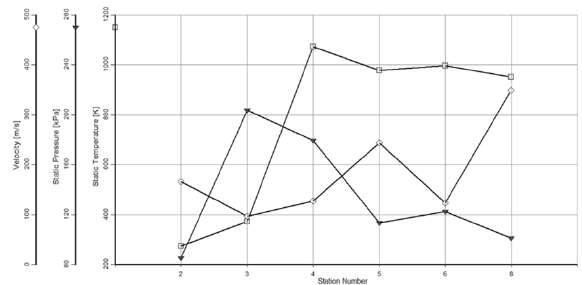
Fig. 4. Aerothermodynamic parameters in the characteristic stations